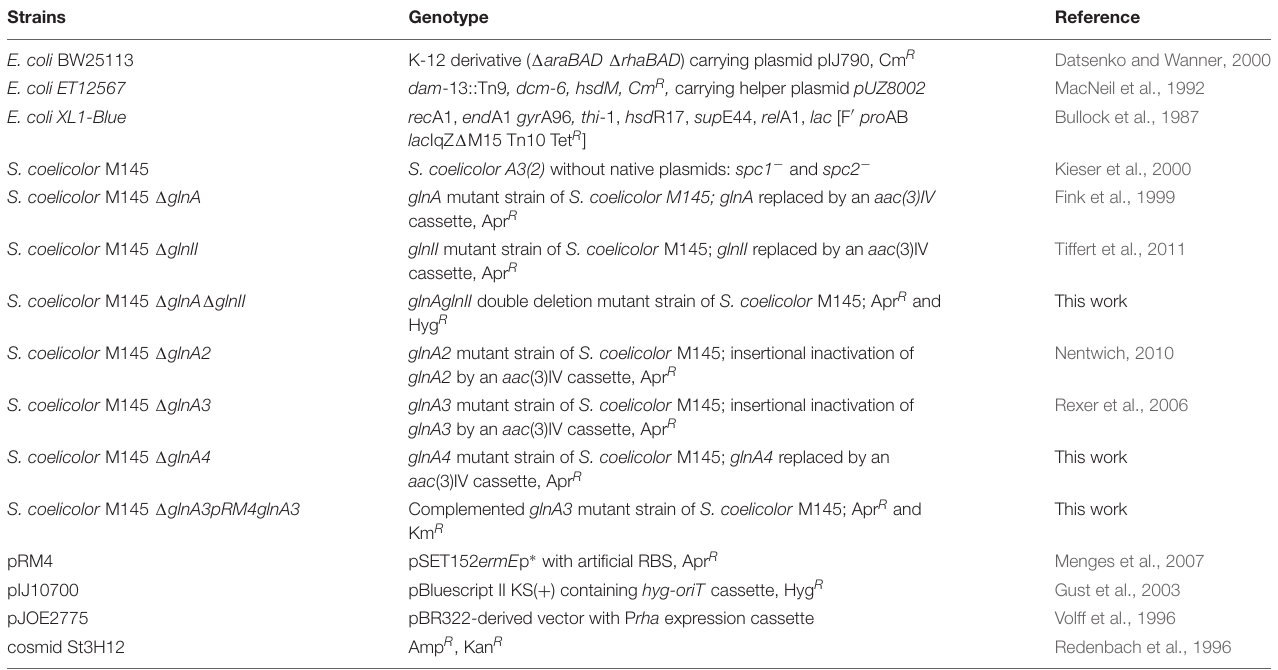
TABLE 1 | Strains and plasmids used in this